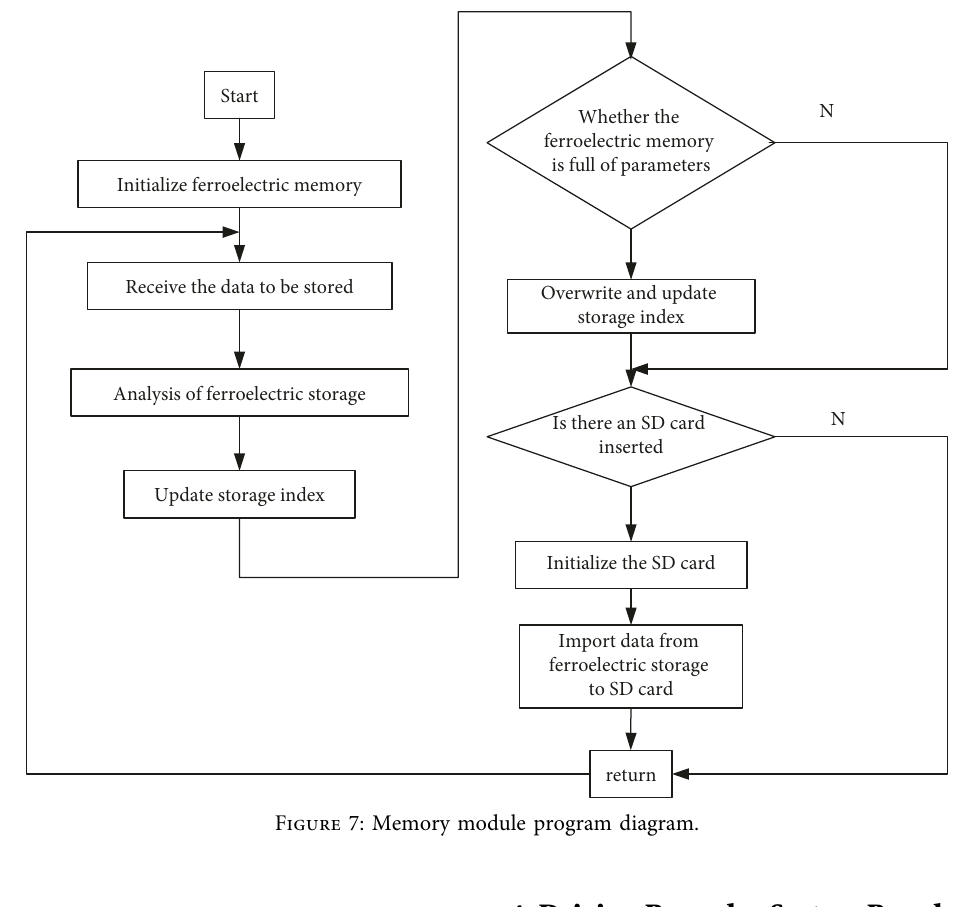
Figure 7: Memory module program diagram.